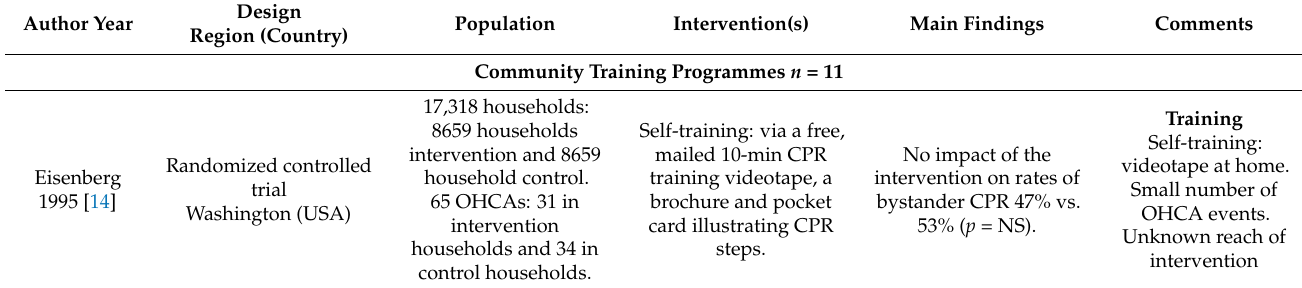
Table 1. Characteristics and outcomes of the included